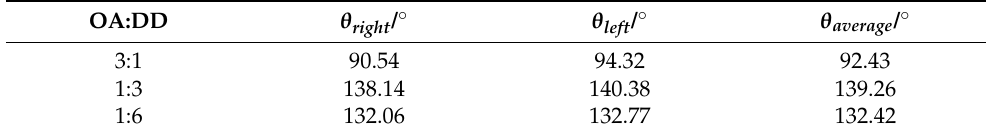
Table 4. Contact angle of the oil film surface after bubble